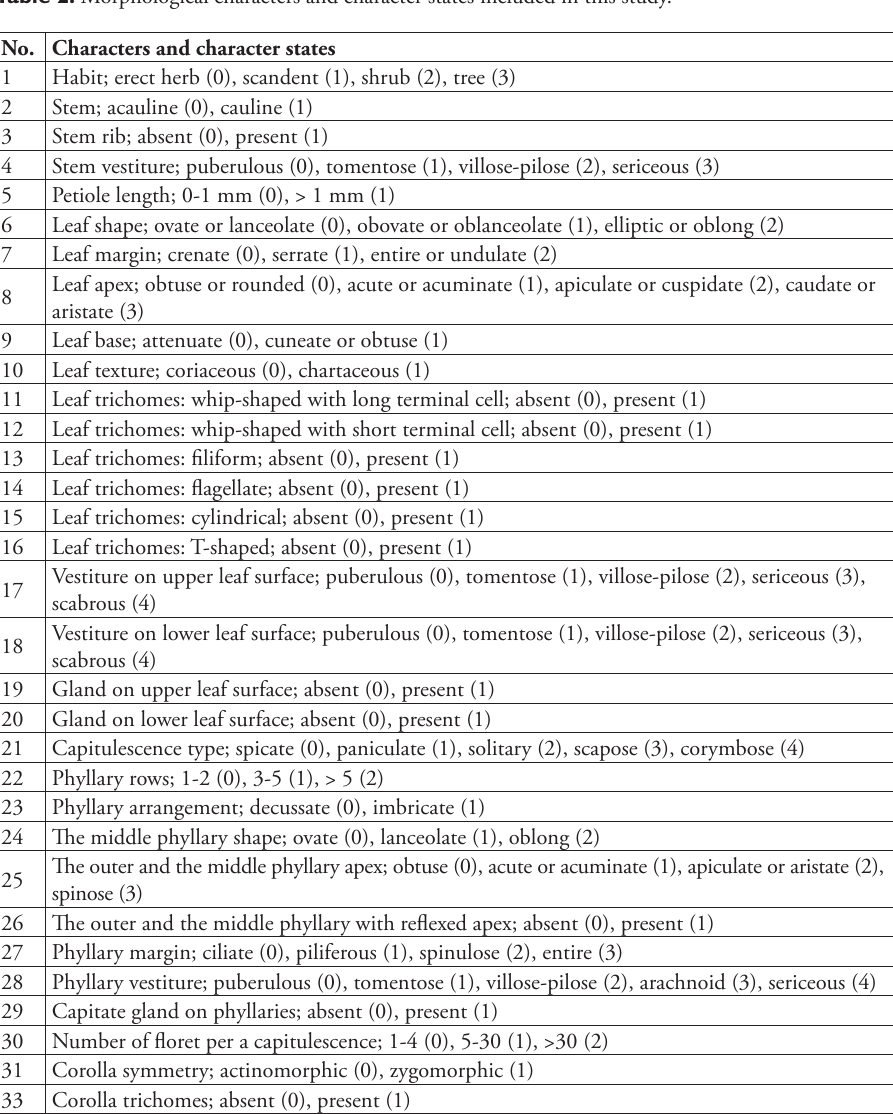
Table 2. Morphological characters and character states included in this study. No. Characters and character